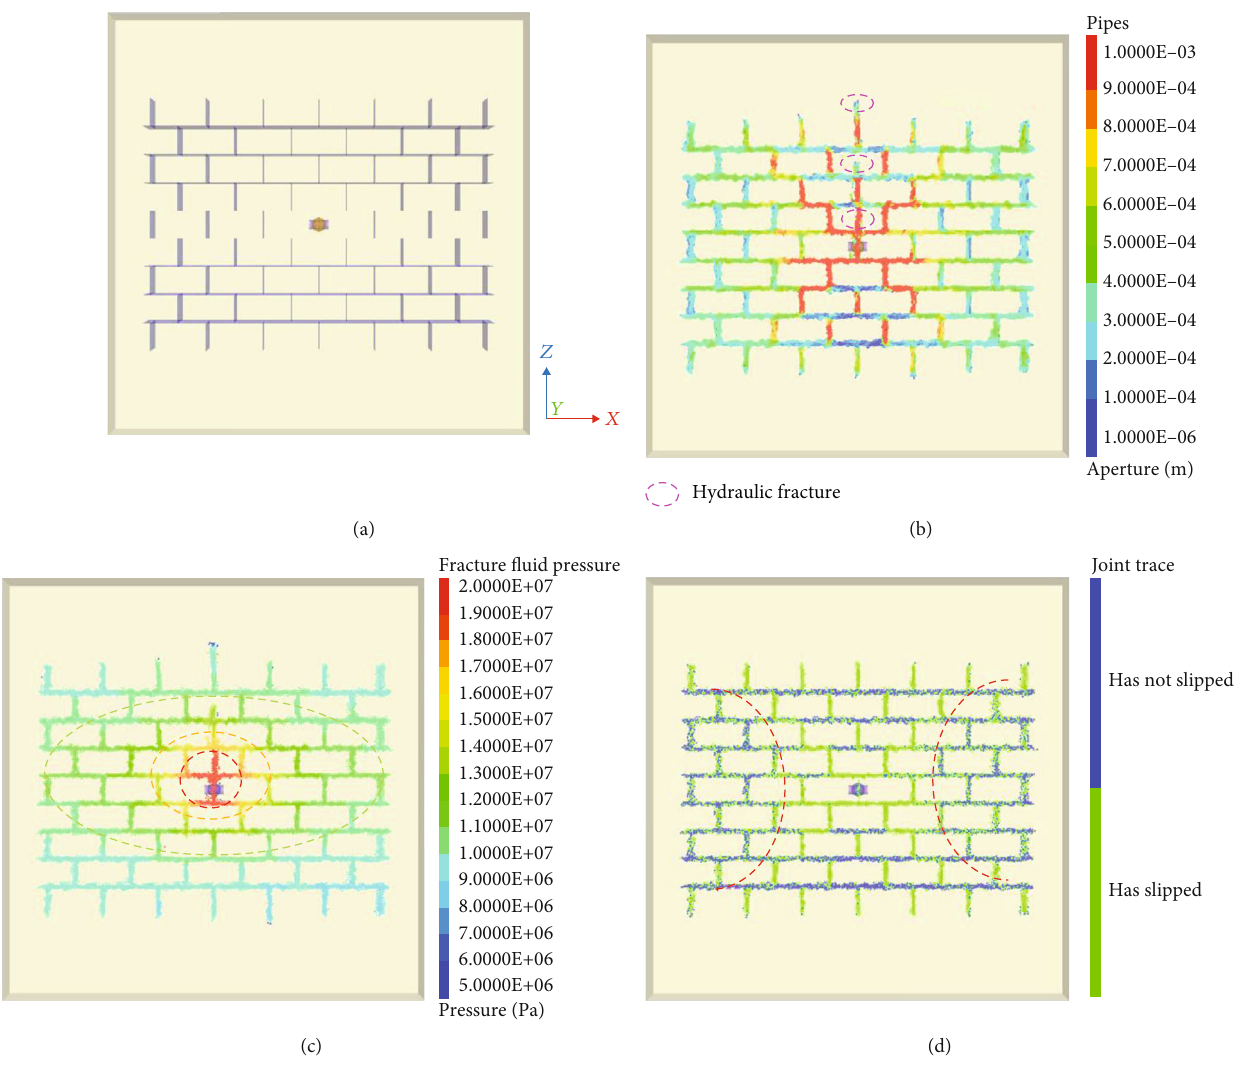
Figure 23: Type C NFN: (a) model setup, (b) fracture aperture, (c) fracture fl uid pressure, and (d) shear slip on the NF.